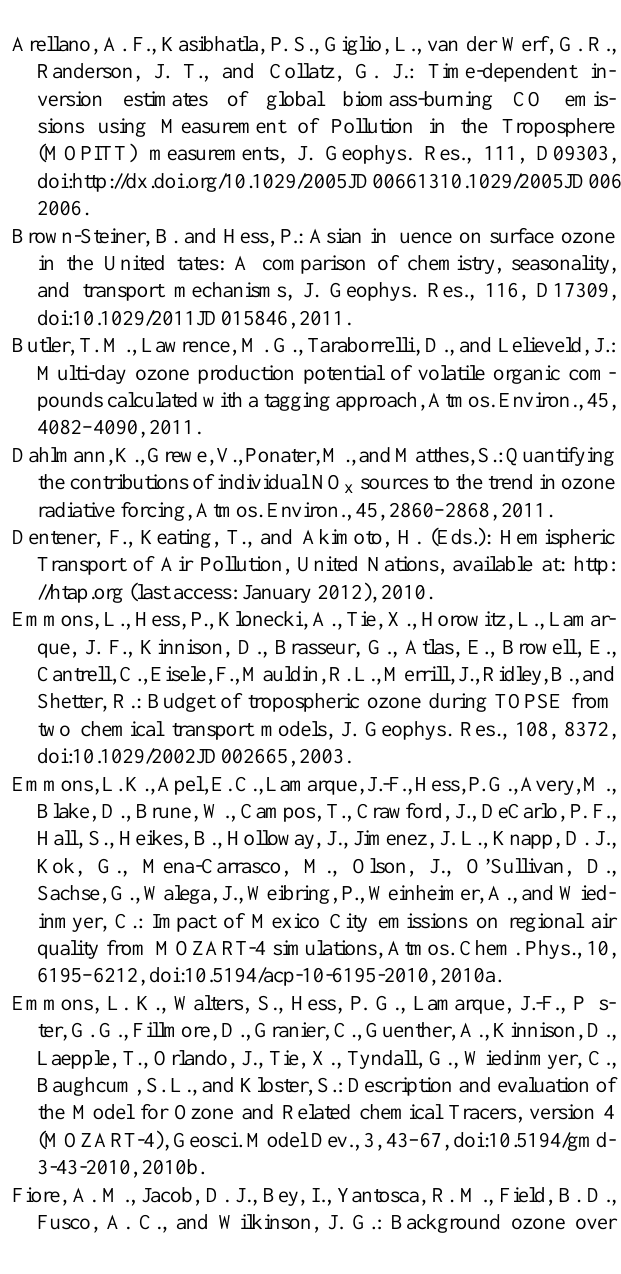
and K 0 (see text) between Tagged P L